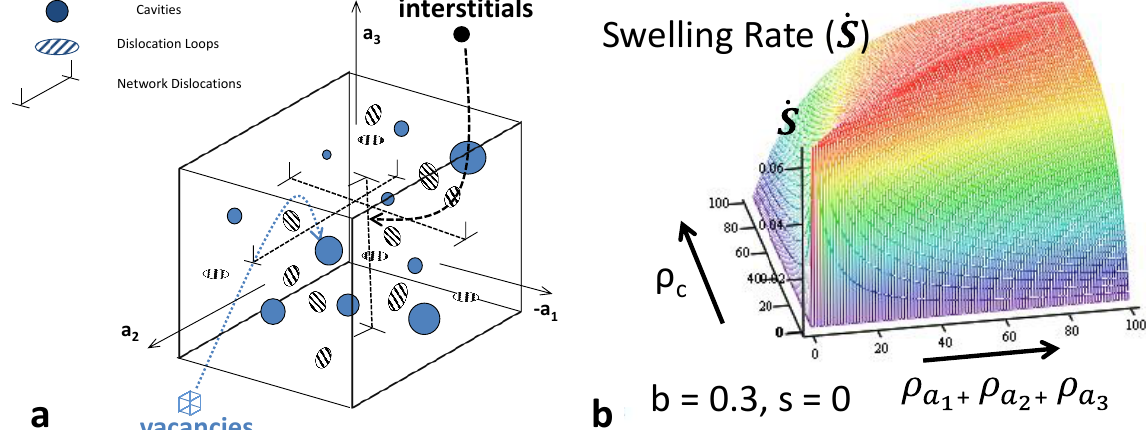
Figure 24. ( a ) Schematic of microstructure and ( b ) rate theory output showing irradiation swelling rate as a function of the relative dislocation (ρ d ) and cavity/void (ρ c ) sink densities/strengths in units of m −2 . The volume swelling rate (% per unit dpa) is a maximum when √1 + 𝑏 · ρ d = ρ c , where b is governed by the size-effect interstitial bias for dislocations ( b ). The output shown is for a nominal 1% cascade damage efficiency and b = 0.3.